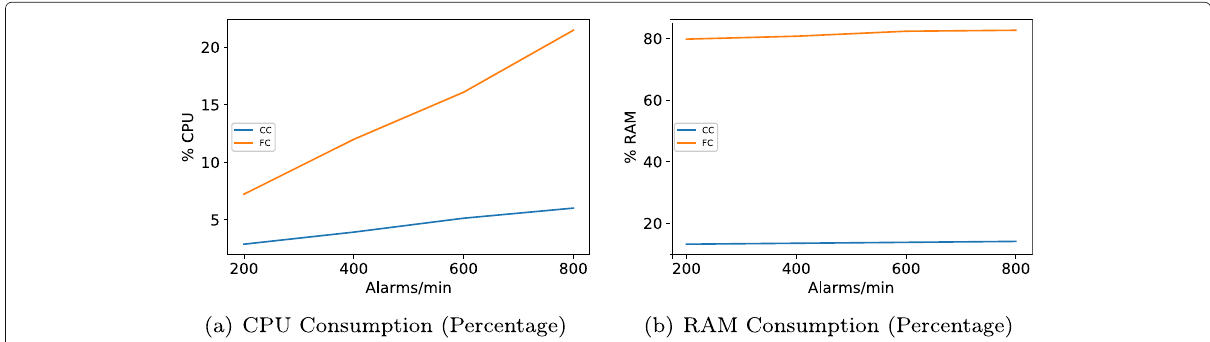
Fig. 12 Performance Breakdown at the Edge Level - Fog Computing (FC) Vs. Cloud Computing